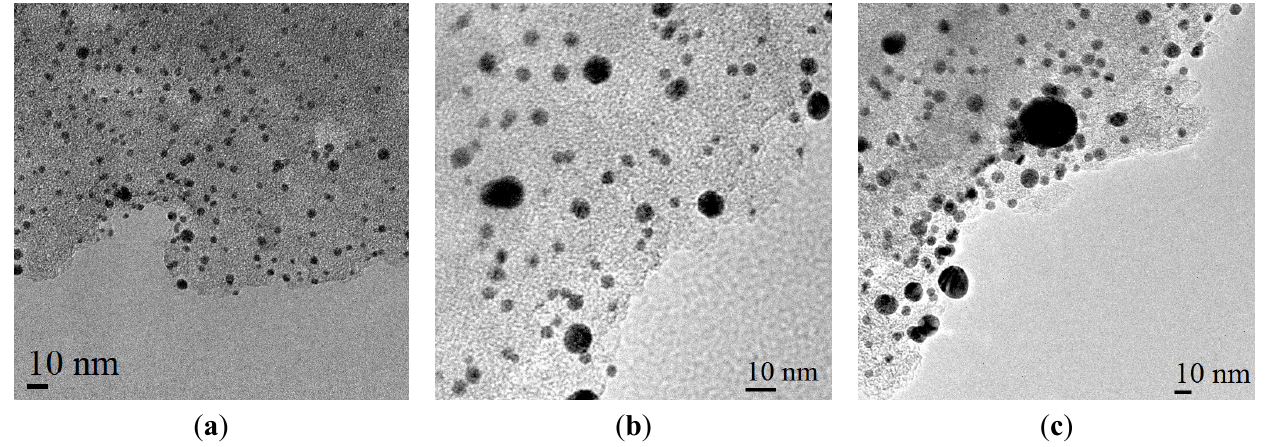
Figure 5. Influence on the sol in the immobilization step on AC ( a ) Au and ( c ) Au citrate